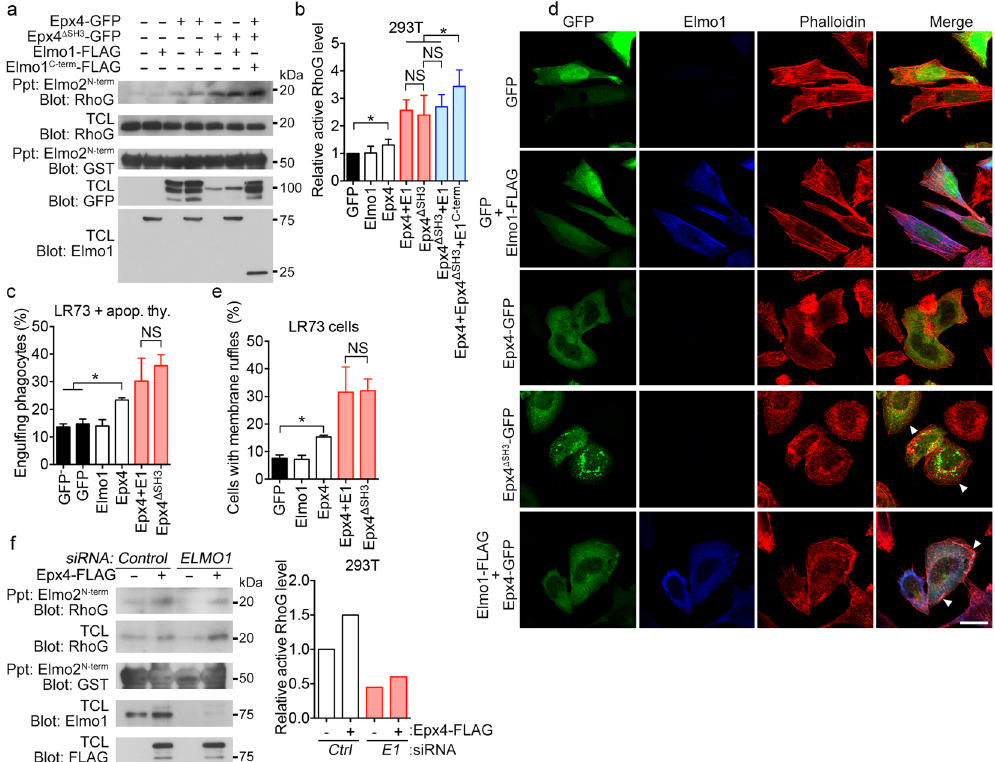
Figure 5. Comparison of the activity of Epheinx4 Δ SH with that of Ephexin4 and Elmo1. ( a , b ) 293 T cells were transfected with the indicated plasmids and lysed. The resultant lysates were incubated with GST-Elmo2 N-term binding to glutathione–Sepharose beads. Co-precipitated endogenous RhoG was detected with anti-RhoG antibody. The assay was performed 3 times. The representative blot ( a ) and quantified data ( b ) are shown. ( c ) The indicated proteins were expressed in LR73 cells, and then the cells were incubated with apoptotic thymocytes for 2 h. LR73 cells ingesting apoptotic thymocytes were analyzed by flow cytometry. ( d , e ) LR73 cells were transfected with the indicated plasmids and stained with Alexa Fluor 488–conjugated phalloidin and anti-Elmo1 antibody ( d ). At least three hundred GFP (and Elmo1) positive cells were analyzed from randomly selected areas of three independent experiments, and GFP (and Elmo1) positive cells with membrane ruffles were counted ( e ). Arrow heads indicate membrane ruffles. Scale bar, 20 µ m. ( f ) 293 T cells were transfected with Ephexin4 and either control siRNA or Elmo1 siRNA. 2 days after transfection, expression of endogenous Elmo1 and overexpressed Ephexin4 were evaluated, and active RhoG levels were detected using the GST-Elmo2 N-term precipitation method (left) and quantified (right). Data are shown as the mean ± standard deviation and are representative of at least three independent experiments. * P < 0.05. Immunoblots are cropped for conciseness and their full-length blots are shown in Supplementary S7. Epx4, Ephexin4; E1, Elmo1; TCL, total cell